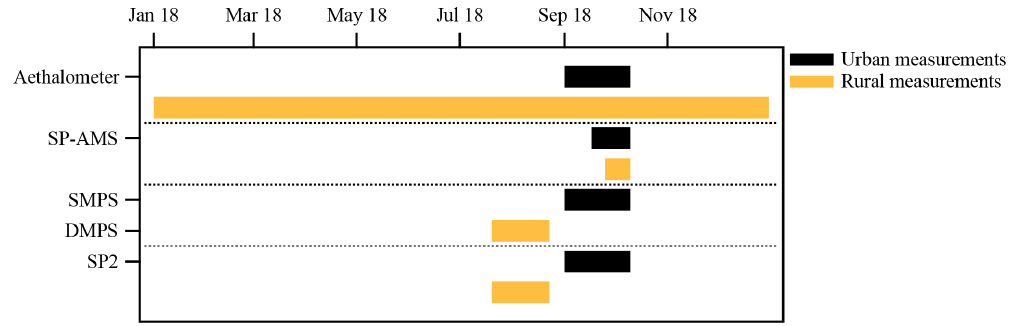
Figure 1. Overview of the data and instruments used. Not shown in the figure are DMA–APM measurements of effective density during spring